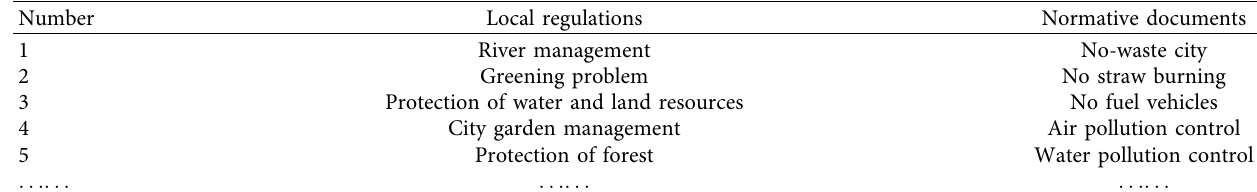
Figure 1: Research Table 1: Themes of ecological and environmental governance in J City.